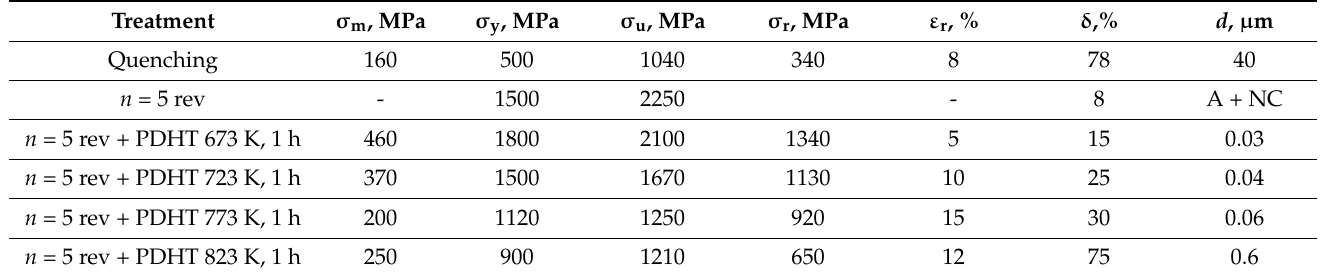
Figure 13. Mechanical σ – ε properties of the Ti 49.4 Ni 50.6 alloy in the quenched state, after HPT with n = 5 revolutions and PDHT at 673, 723, 773, or 823 K for 1 h [75]. Table 4. Mechanical characteristics of HPT (preliminarily treated) Ti 49.4 Ni 50.6 alloy.